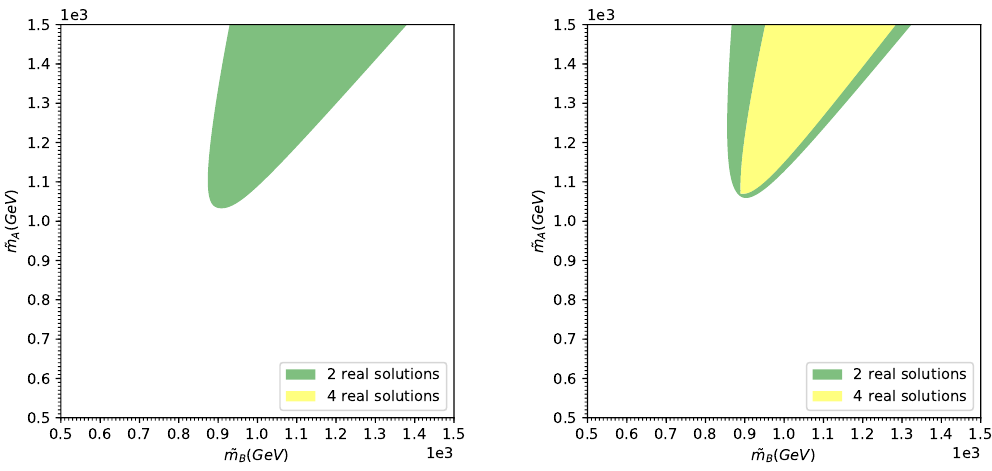
Figure 4 . The same as (cid:12)gure 3, but for a choice of test mass ~ m ~ m = 800 GeV > m C C